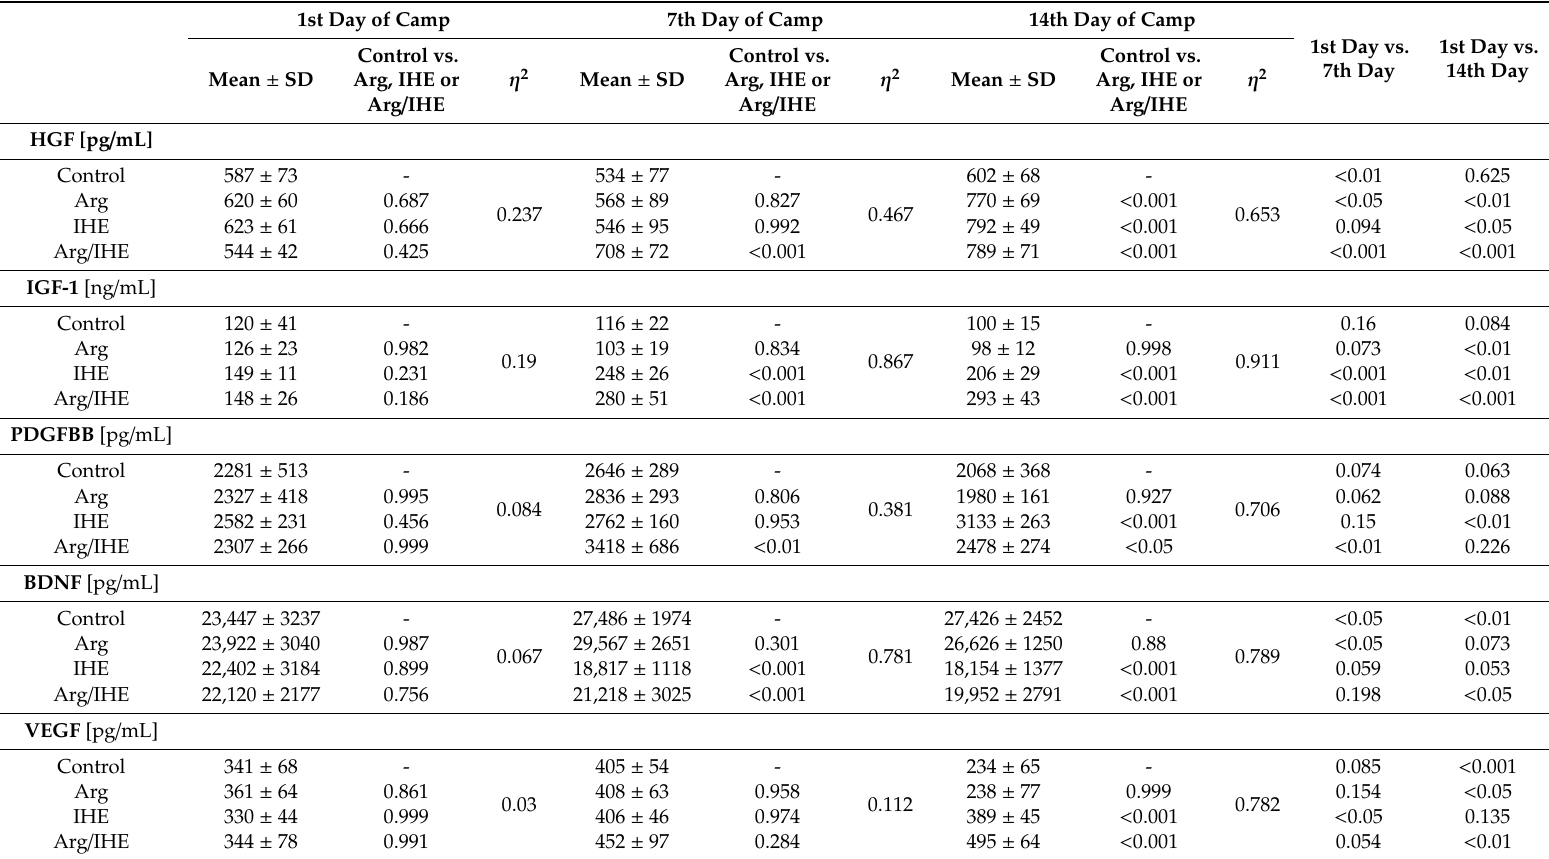
Table 3. The levels of tissue regeneration